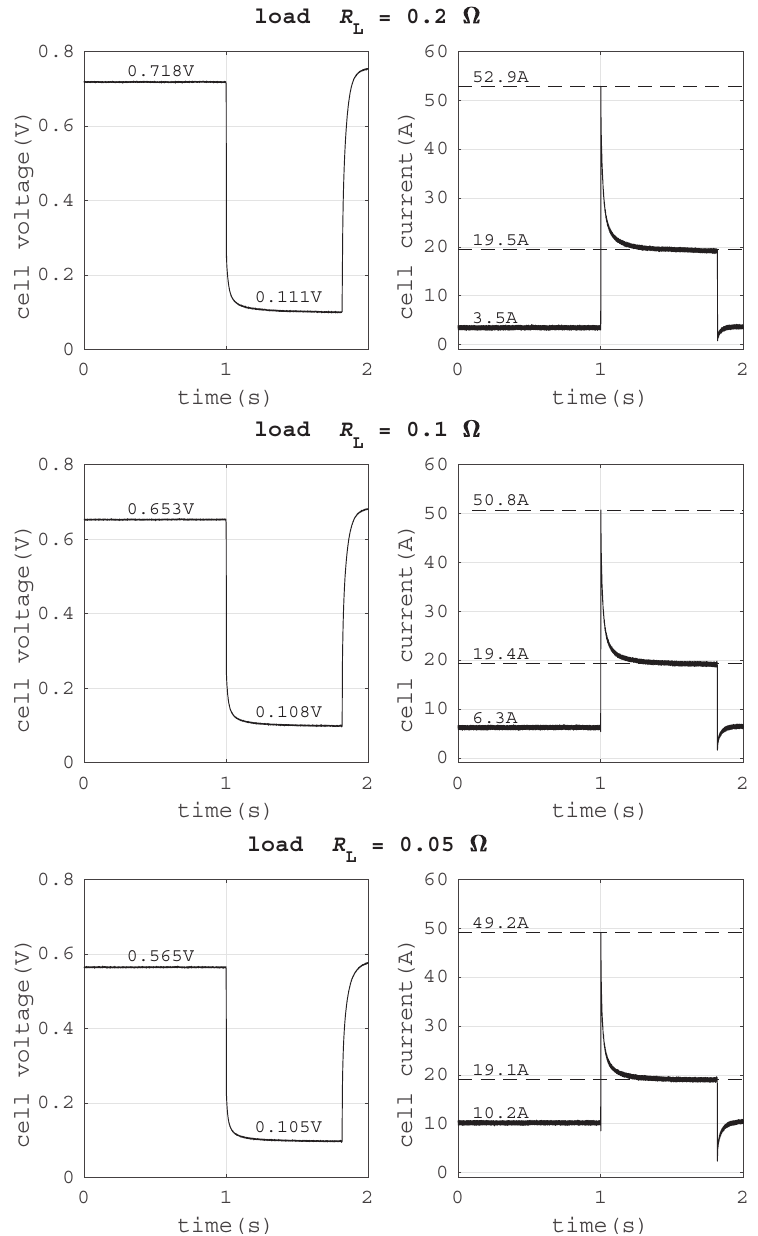
Figure 9. Cell voltage and current behavior for an external short circuit for different ohmic loads: ( top ) Ohmic load of 0.2 Ω , ( middle ) Ohmic load of 0.1 Ω , ( bottom ) Ohmic load of 0.05 Ω